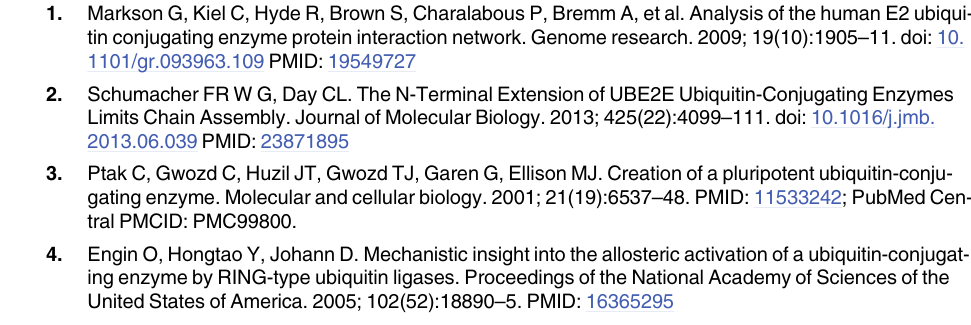
S1 Fig. Phylogenetic tree (NJ tree) of ZmE2s. The NJ tree includes 75 UBC proteins from Zea mays , 15 from Saccharomyces cerevisiae , and 48 from Arabidopsis thaliana . The tree shows 15 phylogenetic subgroups depicted in various colors to distinguish diversification of subfamilies into clusters. S2 Fig. Differential expression levels of ZmUBC genes which increased or decreased by > 15-fold in NaCl treatment, or increased or decreased by > 15-fold in PEG 6000 or 4°C treatment. The X-axis indicates time course/treatment and the Y-axes are scales of relative expression levels. The maize actin gene was used as internal control. The presented data are representative of three independent experiments. S1 Table. Primers used in RT-qPCR of ZmUBC